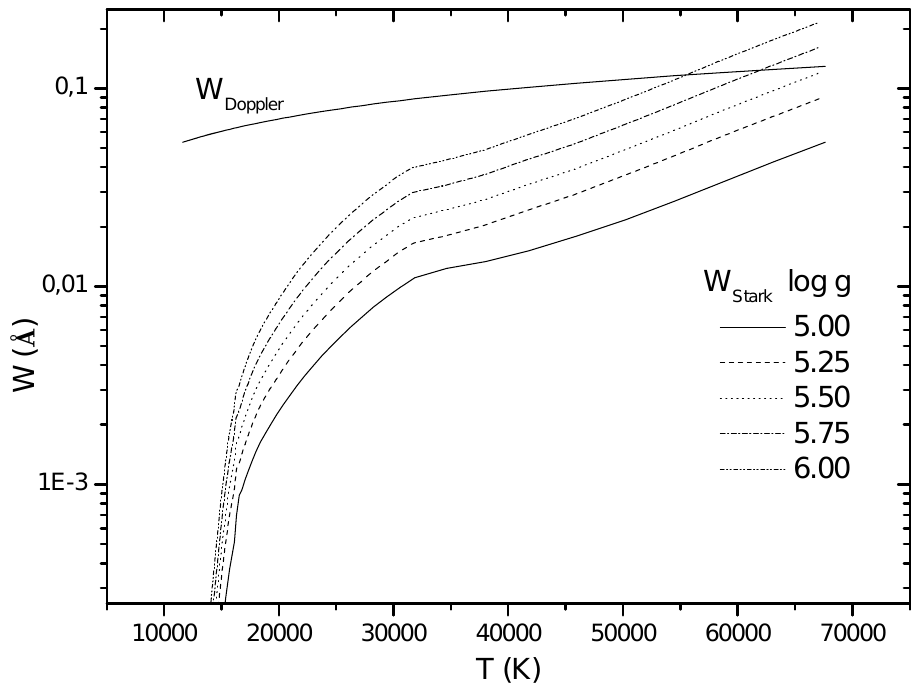
( λ = 4371.33 Å) spectral lines 3/2